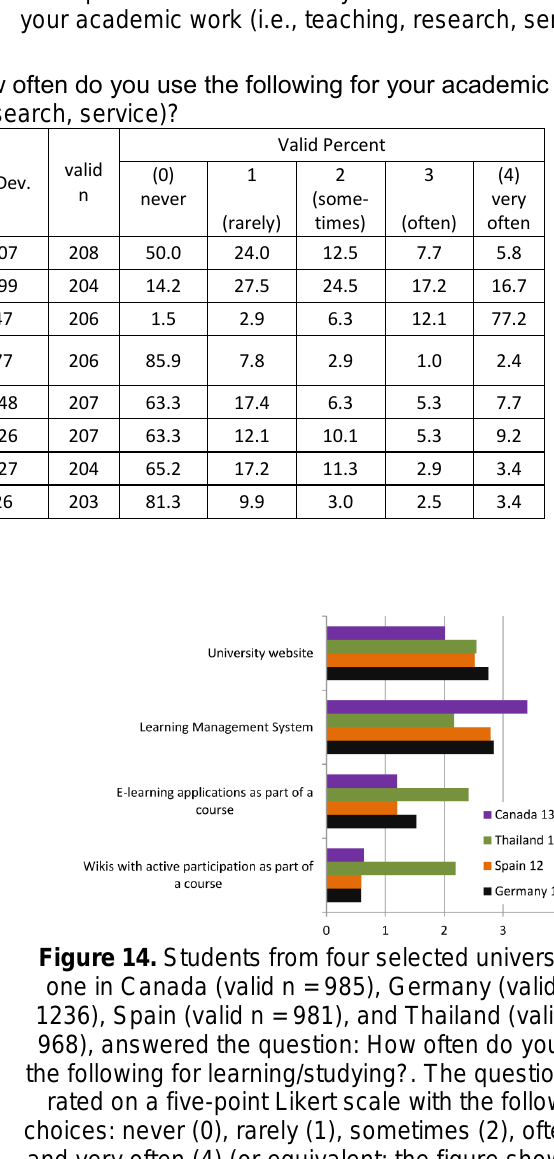
Figure 13. Valid percent of instructors’ responses to the question: How often do you use the following for